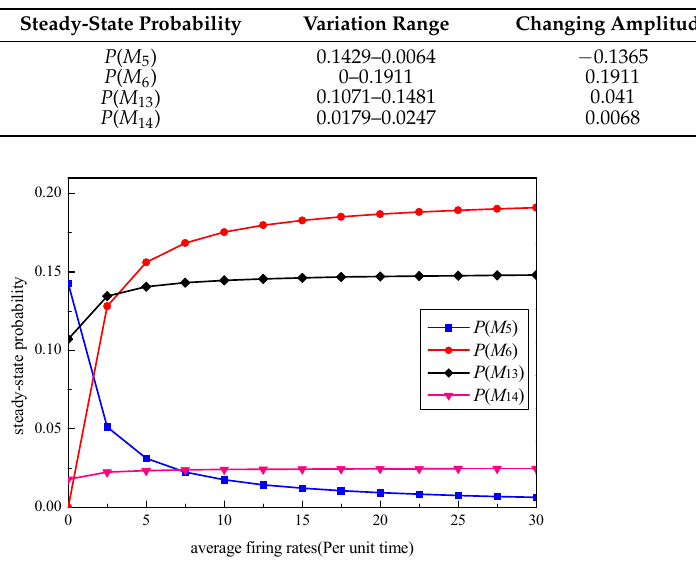
Table 4. Changes in the steady-state probability of each end state when λ 4 changes.